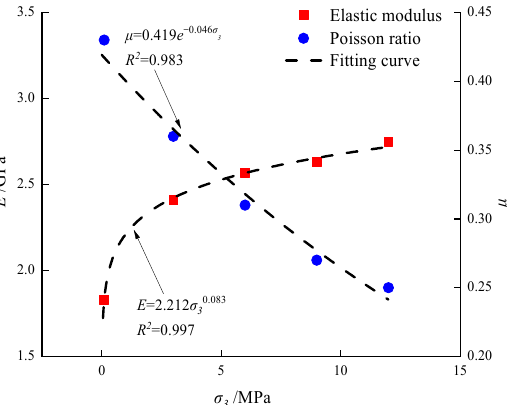
Figure 8. The relationship between elastic modulus, Poisson’s ratio and confining pressure.